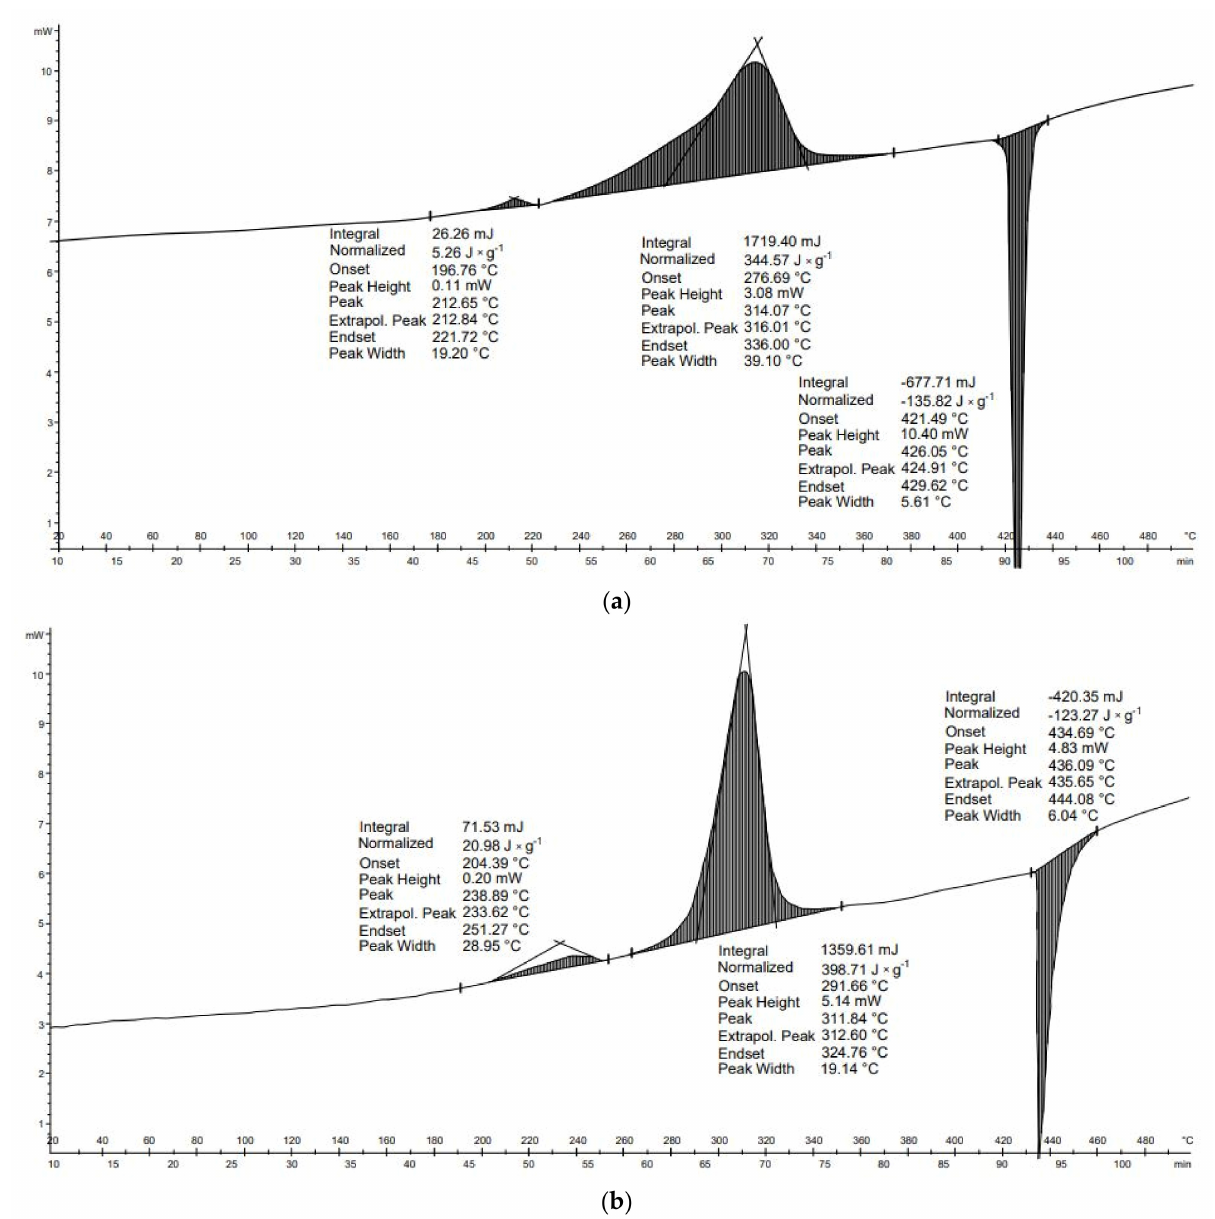
Figure 2. Characteristics of the DSC of paper waste: ( a ) receipts; ( b ) cotton wool. The energy balance determines the energy of transformations occurring during the thermal conversion process of the tested materials (Table 3). Reactions are divided into exothermic and